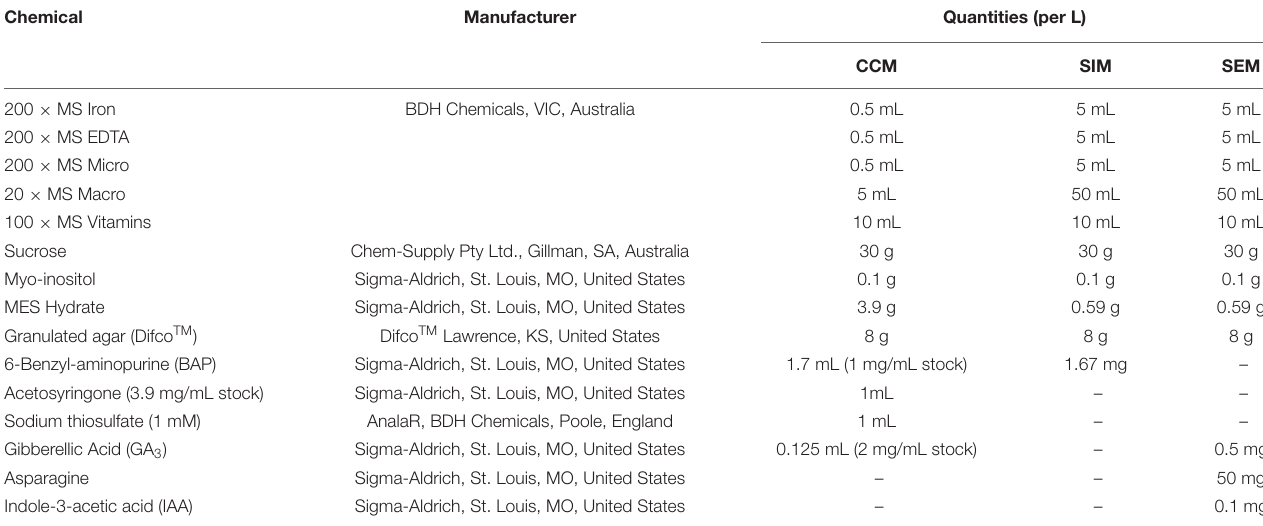
TABLE 3 | Composition of cowpea co-cultivation medium (CCM), shoot induction medium (SIM) and shoot elongation and rooting medium (SEM). Chemical